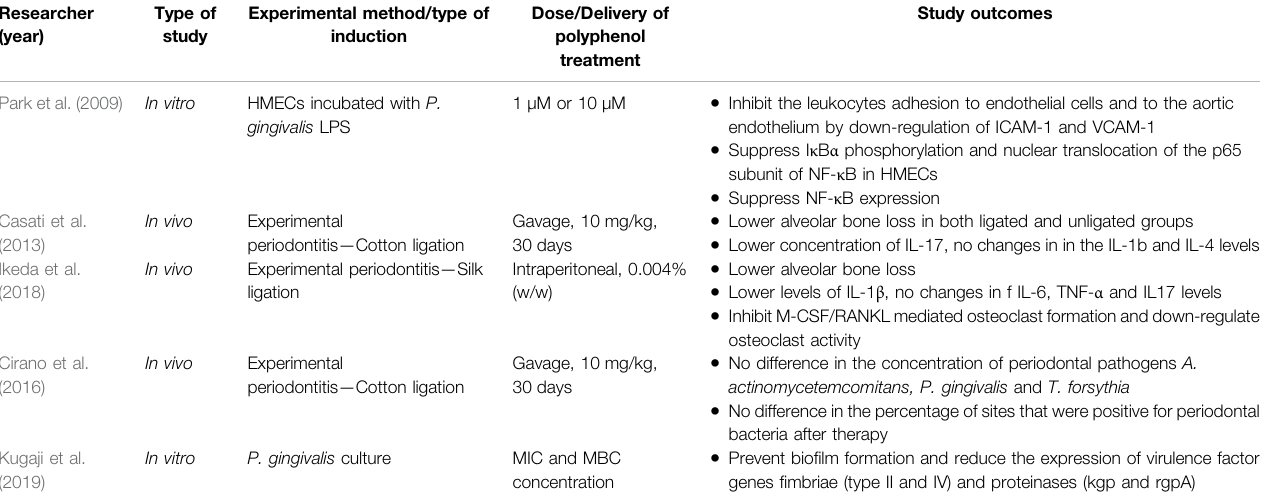
TABLE 2 | The effects of resveratrol in periodontal in fl ammation, in vivo and in vitro